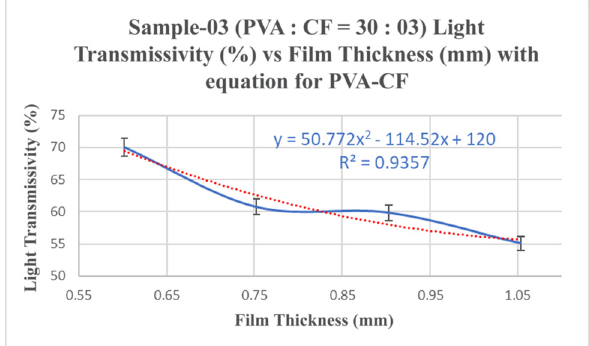
Figure 18: Sample - 03 ( CF:PVA = 0.3:30 ) light transmittance ( % ) versus fi lm thickness ( mm ) with equation for PVA - CF. The dotted lines represent the polynomial fi tted curve and the linear fi tted.